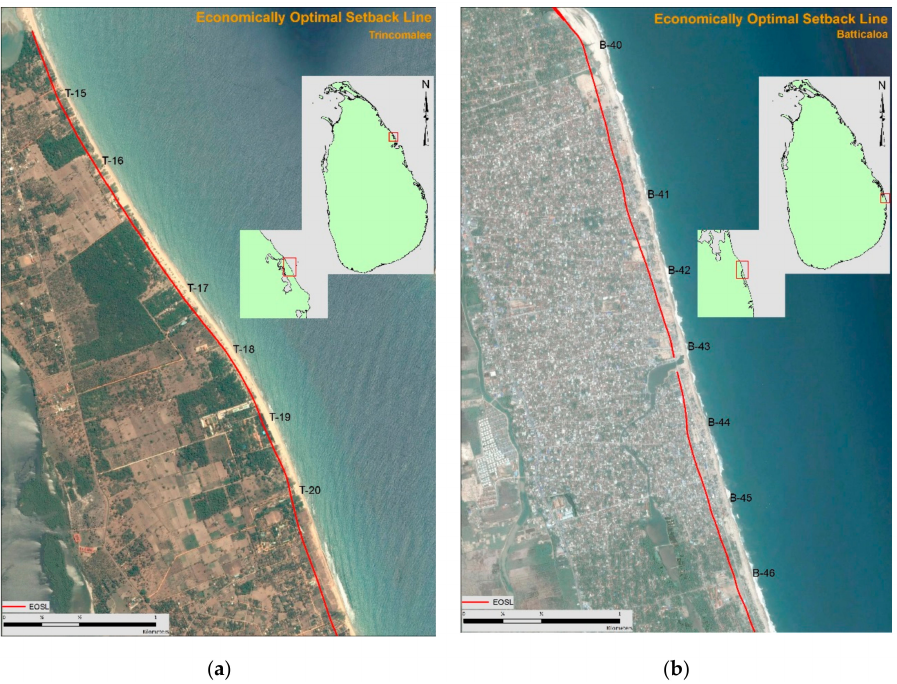
Figure 21. Examples of estimated economically optimal coastal setback lines in Trincomalee ( a ) and Batticaloa ( b